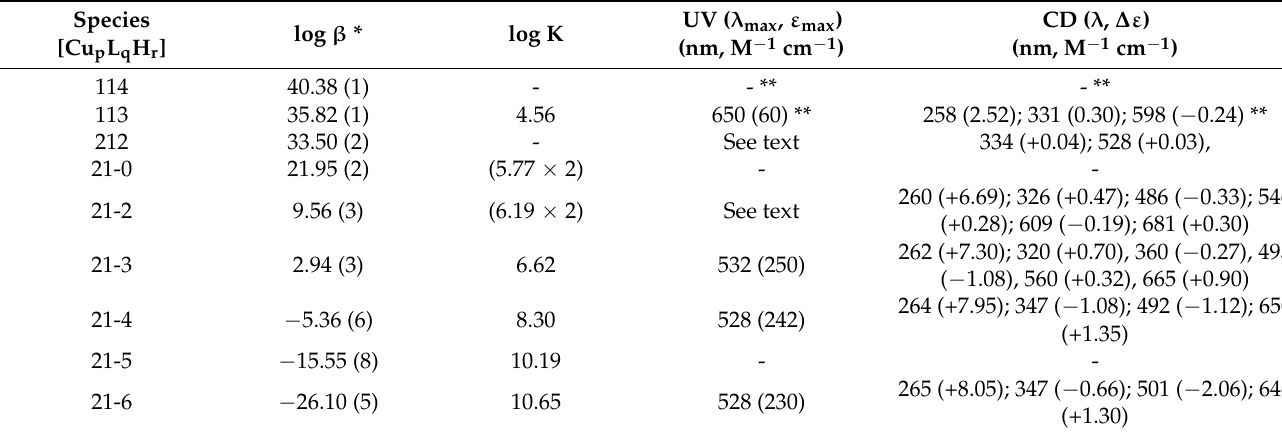
Table 2. Log β and log K values obtained from the titration of the Cu-AcAng1-17 system (2:1), by varying the solution pH in the range